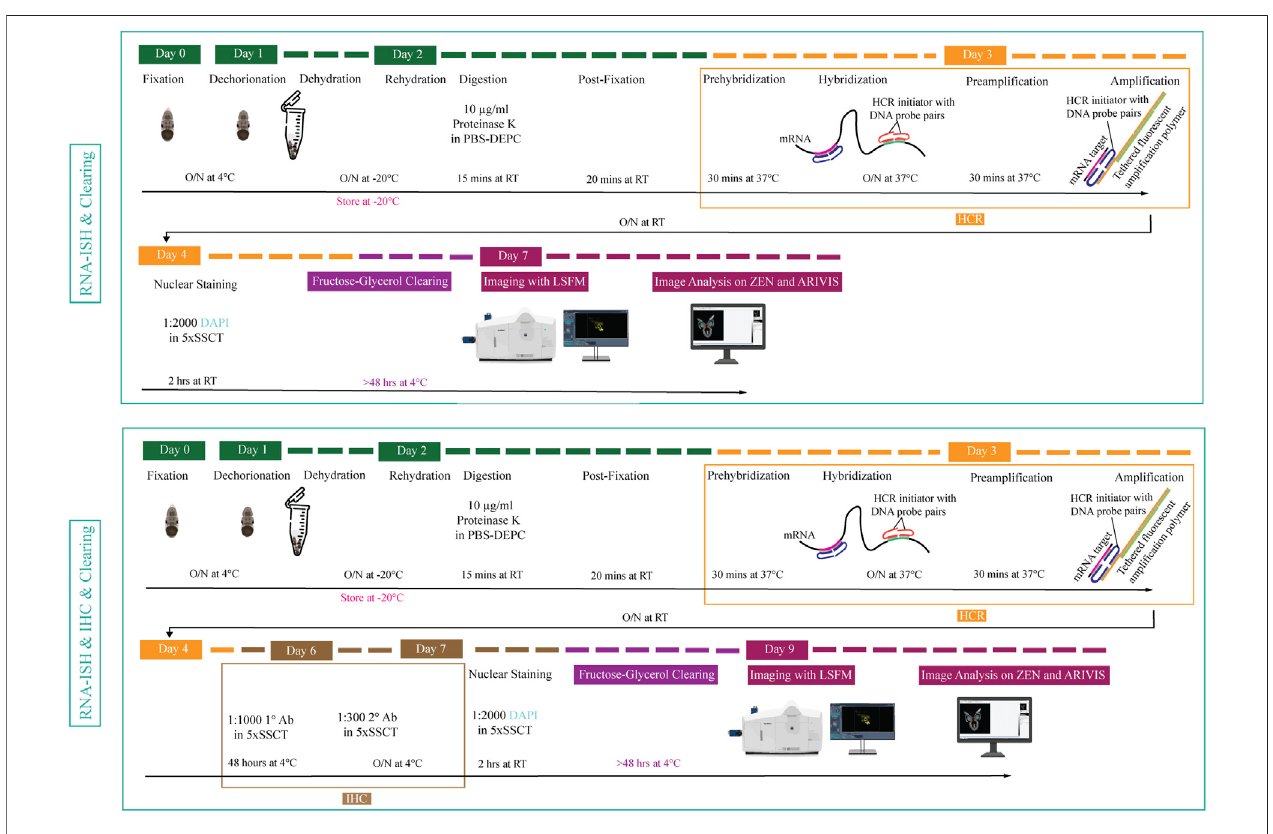
FIGURE 1 | Overview of experimental pipeline for Octopus vulgaris embryos. RNA in situ hybridization chain reaction version 3.0 (RNA-ISH) and immunohistochemistry (IHC) arefollowedby fructose-glycerolclearing and imaging withLight Sheet Fluorescence Microscopy (LSFM).The fi nal images (3Dimages and Z-stack planes) as well as videos are acquired, processed and analyzed with ZEN (black edition) and ARIVIS VISION4D v.3.1.4 software. For developmental stage XV embryo (its size is approximately 1,25 mm x 0,88 mm), RNA-ISH & Clearing & Imaging & Image Analysis takes approximately 7 days whereas, RNA-ISH & IHC & Clearing & Imaging & Image Analysis takes around 9 days. (This fi gure is designed using a resource from freepik.com).